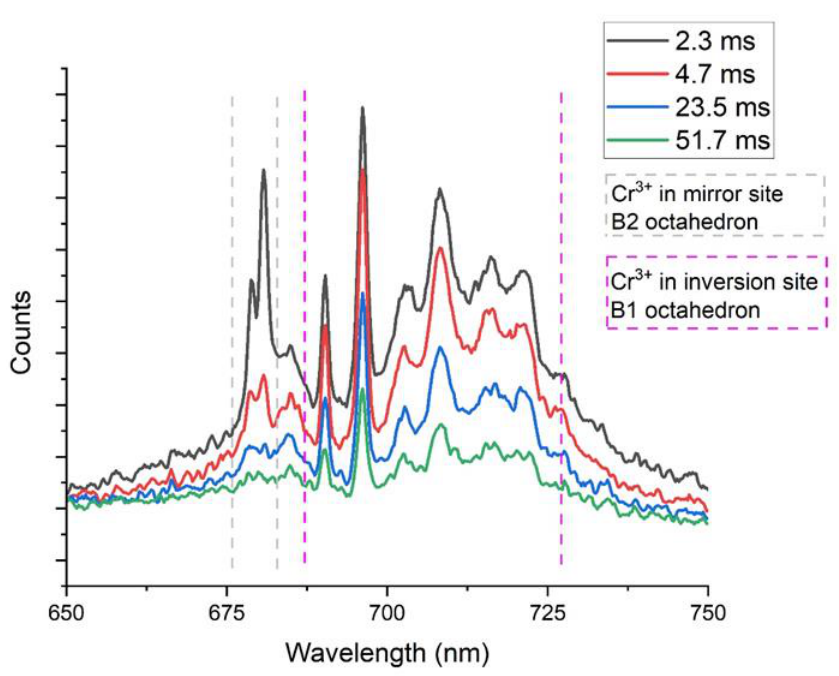
Figure 7. Time-resolved fluorescence decay spectra of alexandrite.